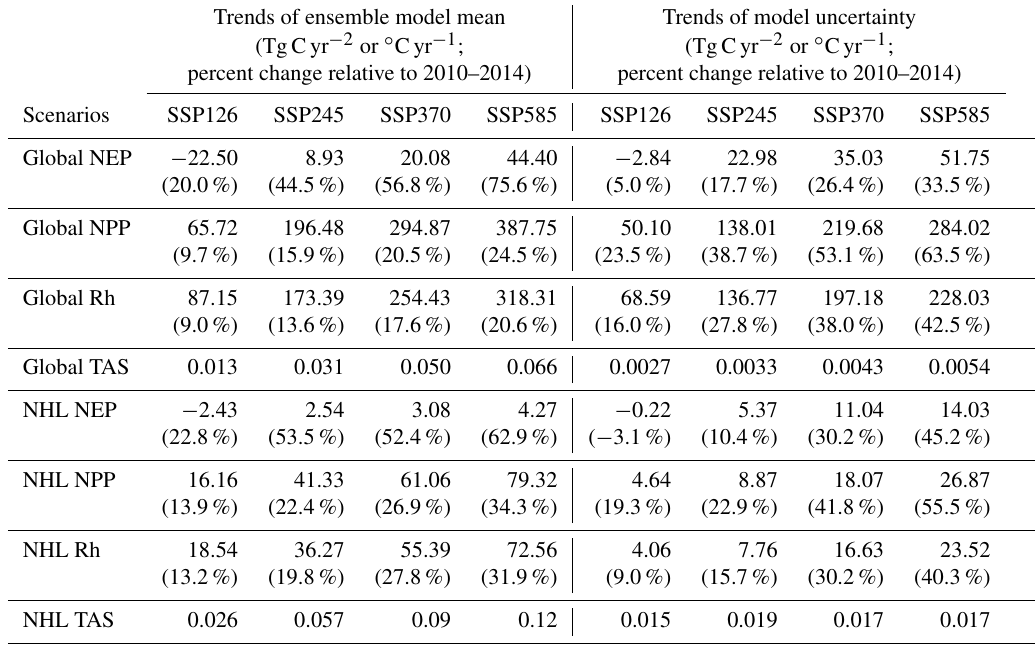
Table 2. Future trends and percent changes relative to 2010–2014 for the multi-model mean NEP, NPP, Rh, and TAS as well as their uncertainties (SD across models) of the 10 CMIP6